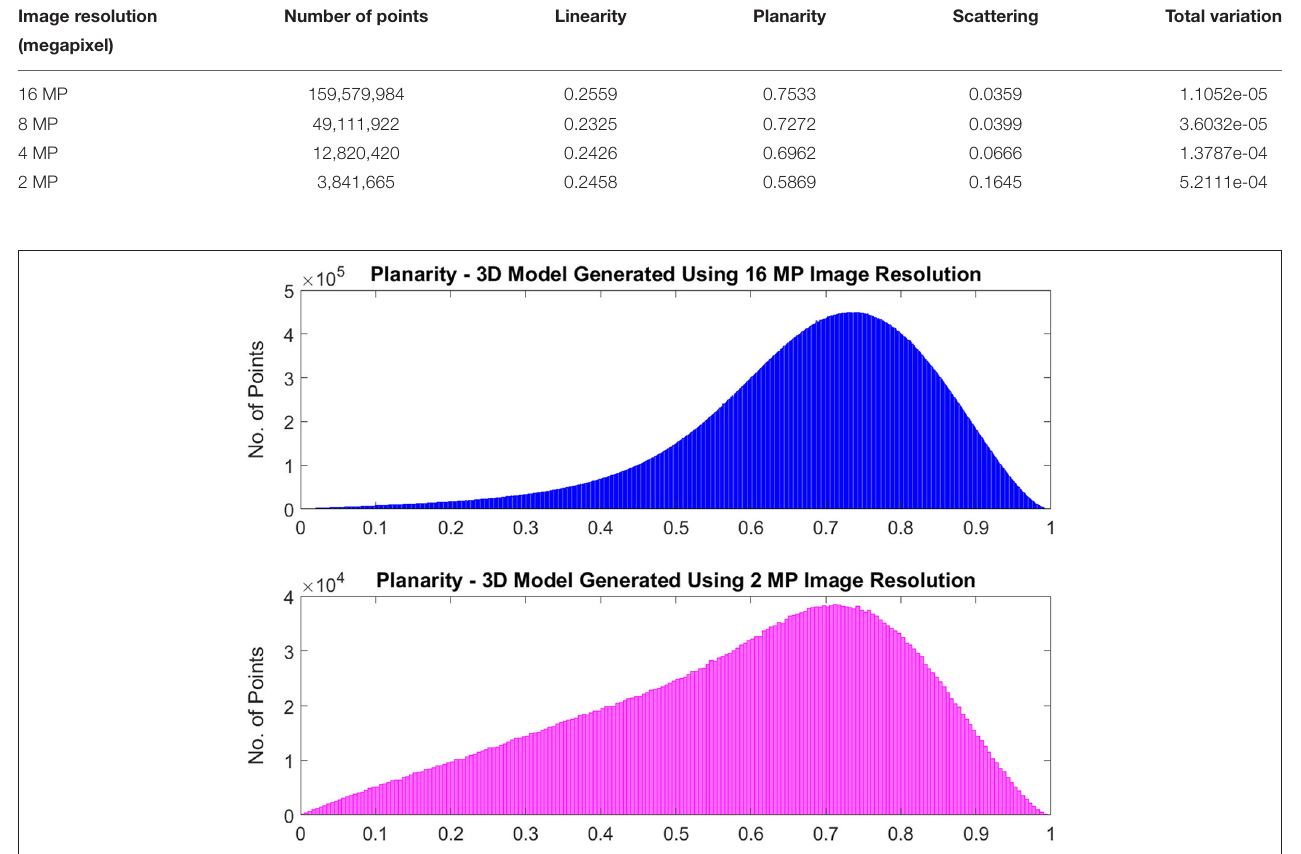
FIGURE 12 | Comparison of planarity values in models generated using different image resolutions.